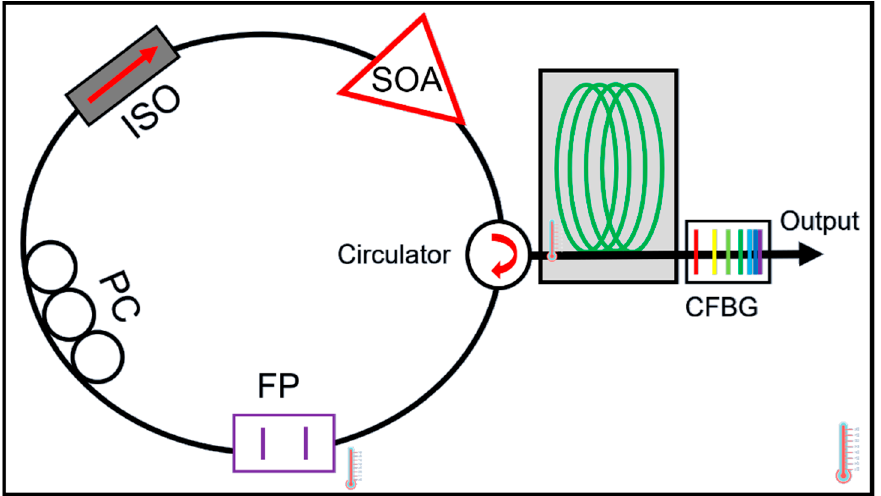
Figure 8. Schematic of an FDML laser with chirped fiber Bragg grating. It comprises a 1310 nm semiconductor optical amplifier (SOA), a fiber polarization controller (PC), a fiber optics isolator (ISO), a fiber Fabry–Pérot filter (FFP) driven at 411 kHz, a mixed fiber spool and a custom made chirped fiber Bragg grating (CFBG). Adapted with permission from Ref. [14].